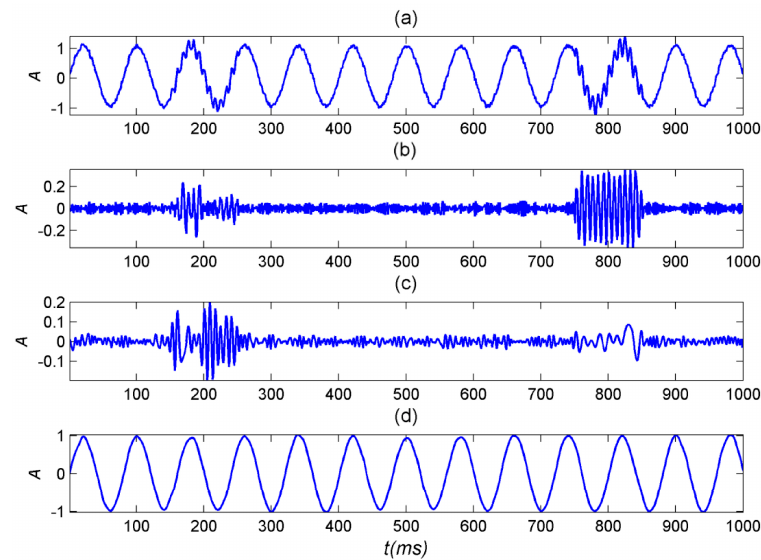
Figure 3. Analysis results of the simple artificial signal with 15% noise using CEEMD: ( a ) the signal; ( b ) IMF1 of the signal; ( c ) IMF2 of the signal; and ( d ) IMF3 of the signal.